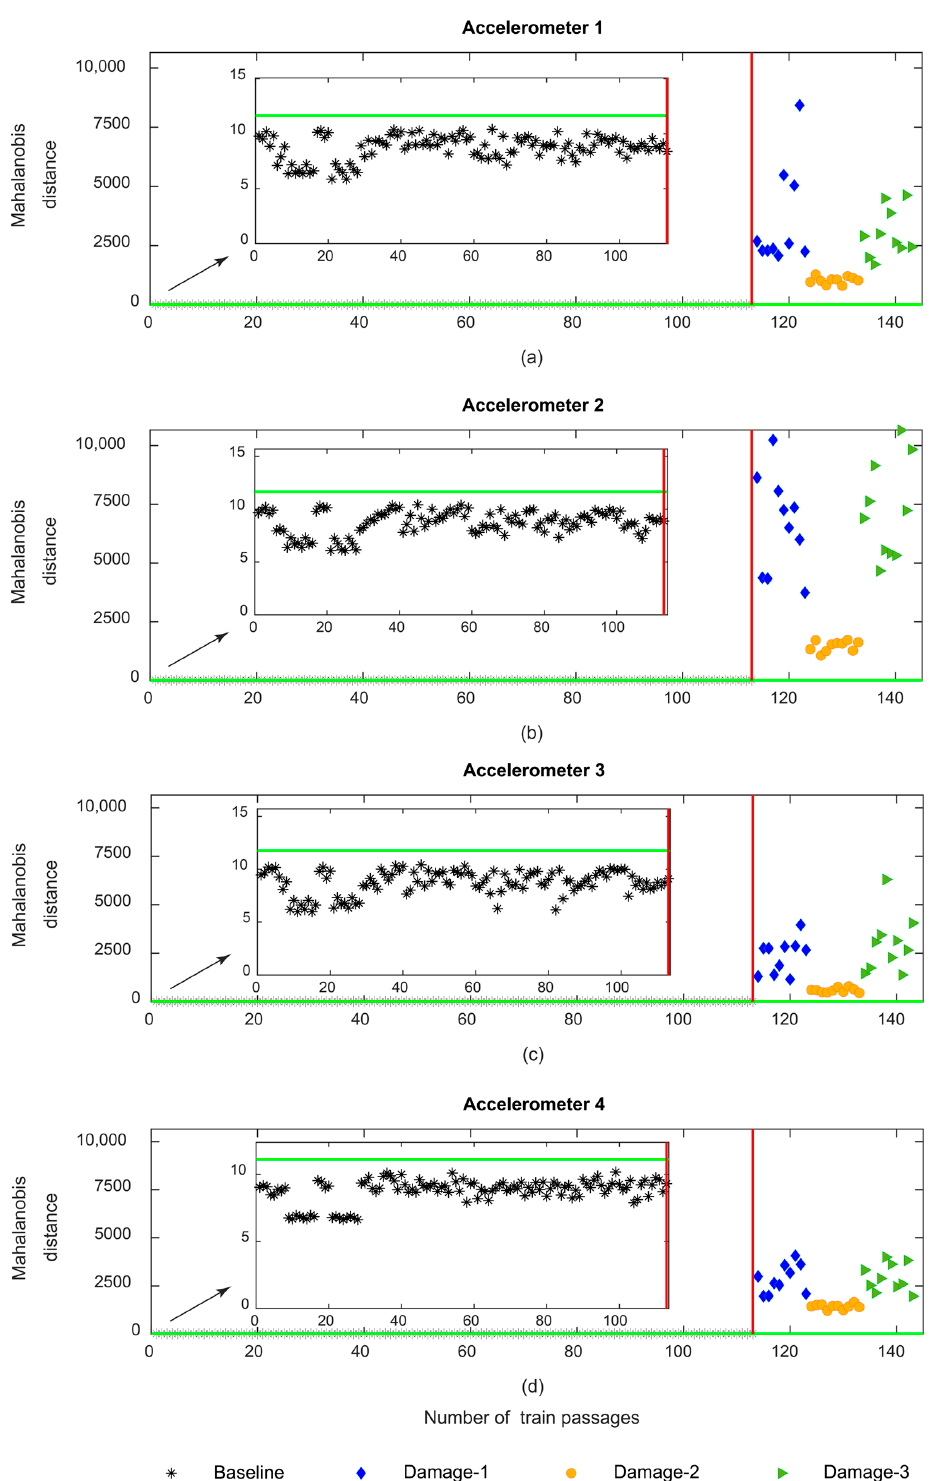
Figure 21. ARX—automatic wheel flat damage detection considering the responses from accelerometers 1–4: ( a ) MD for accelerometer 1, ( b ) MD for accelerometer 2, ( c ) MD for accelerometer 3, ( d ) MD for accelerometer 4.